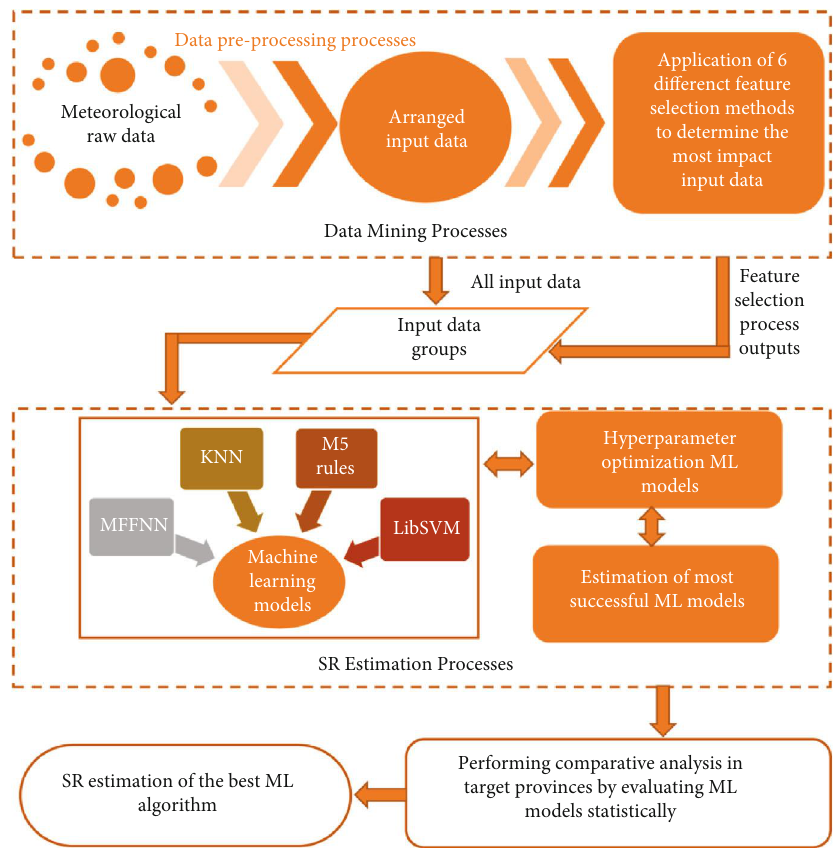
Figure 1: The framework of methodology of the present